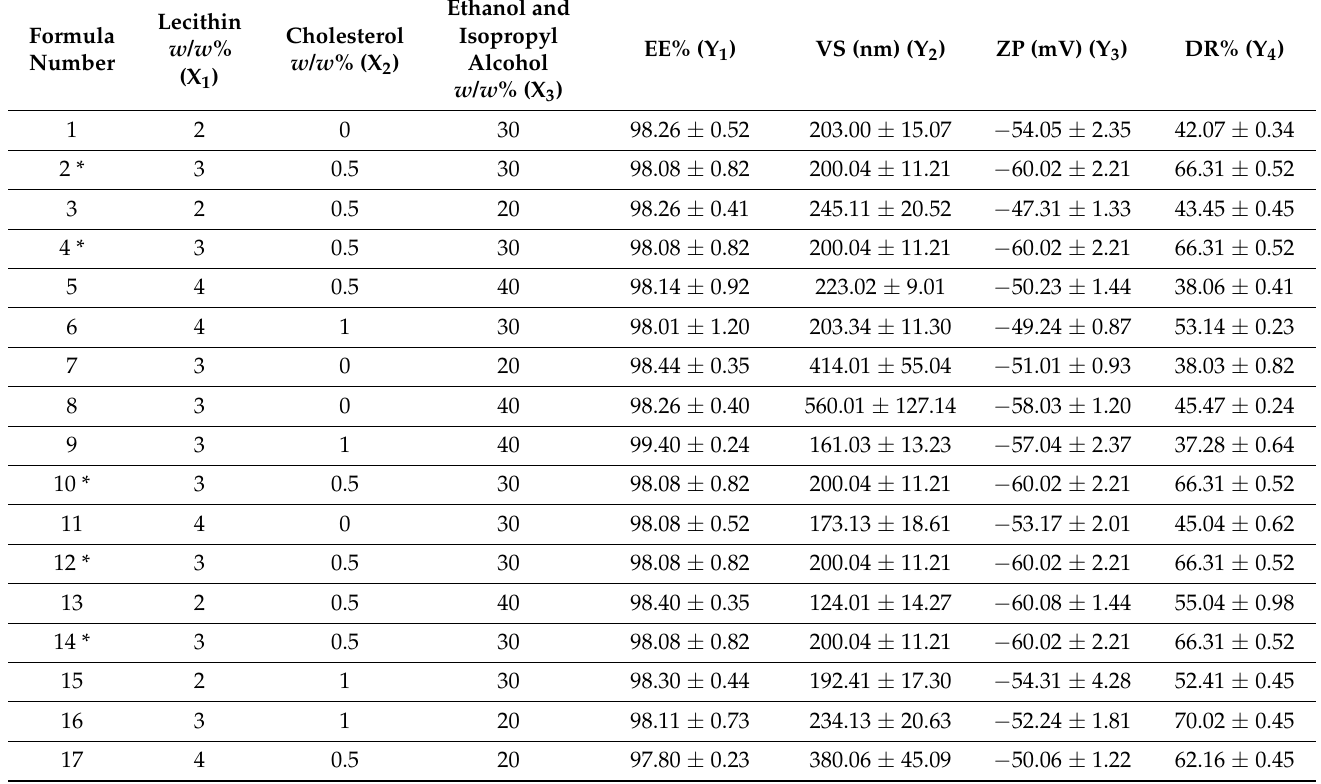
Table 1. Effect of the independent variables on the EE%, VS, ZP and